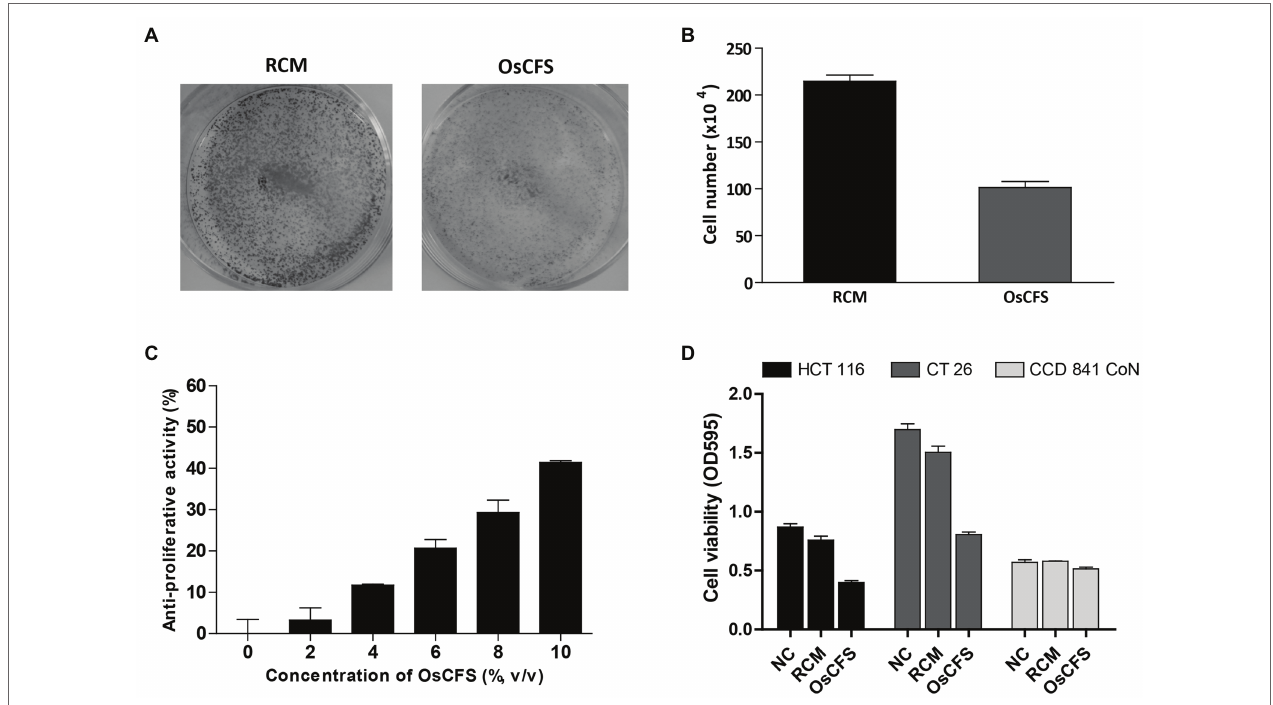
FIGURE 1 | Anti-proliferative activity of the Odoribacter splanchnicus cell-free supernatant (OsCFS) in a cell-based system. Data are expressed as mean ± standard error of three independent experiments. (A) The crystal violet staining assay after RCM or OsCFS treatment in HCT 116 cells. (B) The differences in cell number after treatment of HCT 116 cells with RCM or OsCFS for 3 days. (C) The dose-dependent effects of OsCFS in an anti-proliferative assay. (D) The selective inhibiting activity of OsCFS observed in colorectal cancer cells (HCT 116, CT 26) but not in normal colon cells (CCD 841